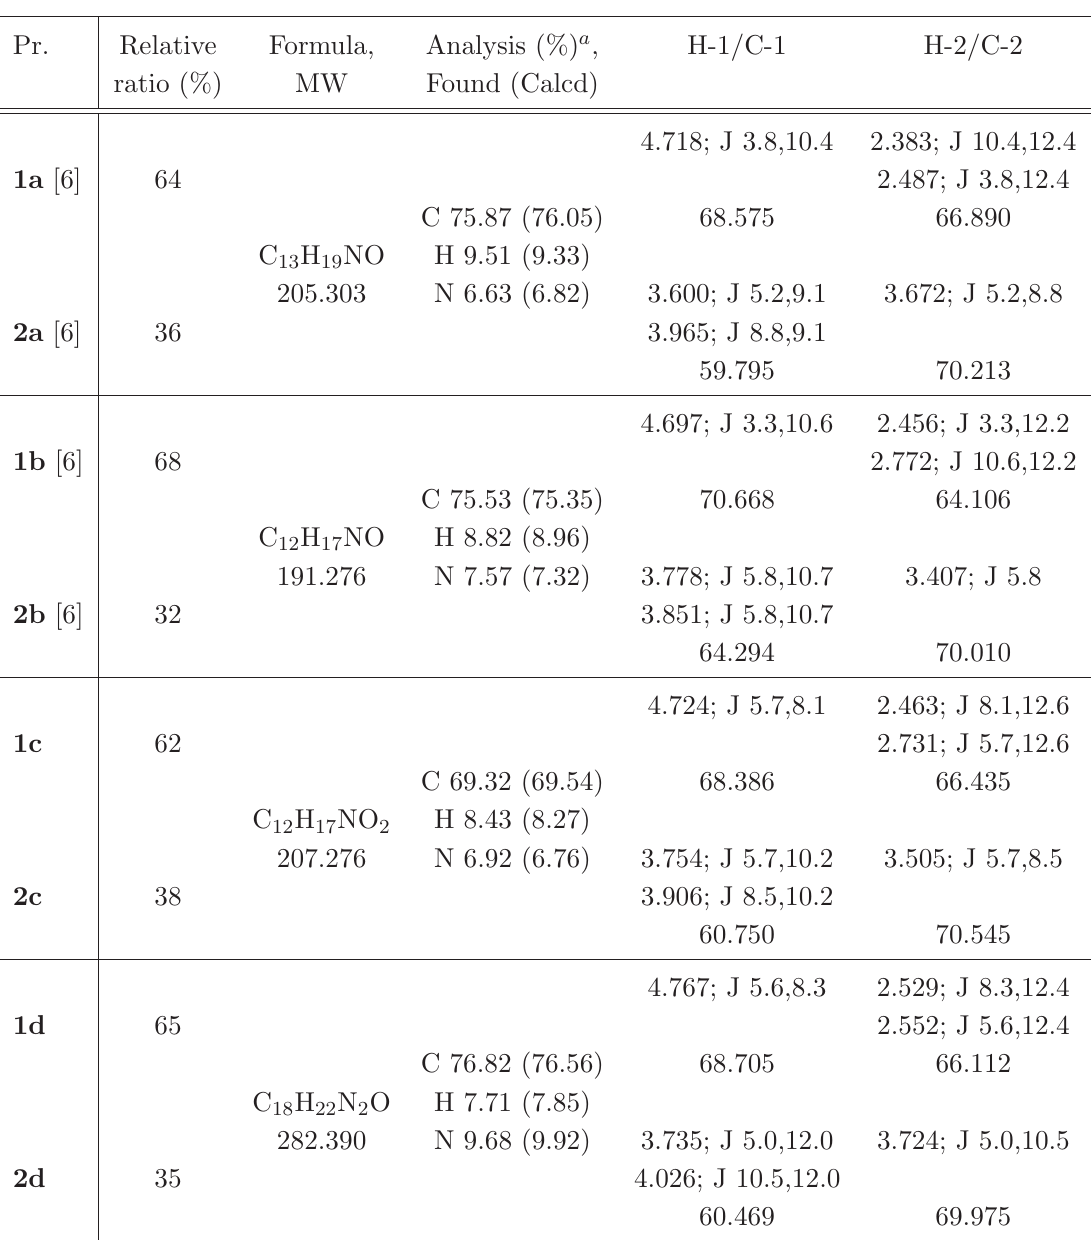
Table 1 Relative ratios (as determined by 1 H NMR) and analytical and NMR data (CDCl 3 , δ referenced to TMS as an internal standard, J in Hz) of the skeleton nuclei of amino alcohols 1 and 2